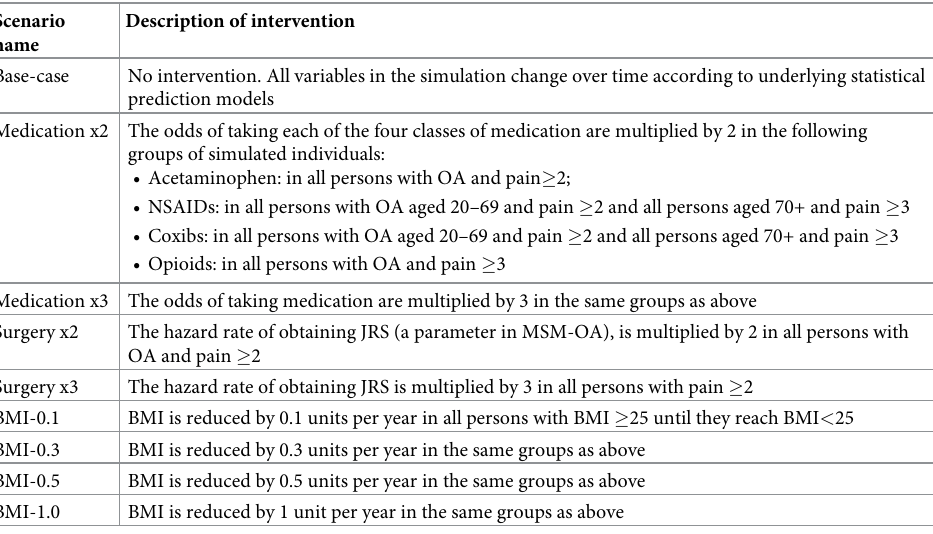
Table 1. Description of the scenarios for inter-strategy